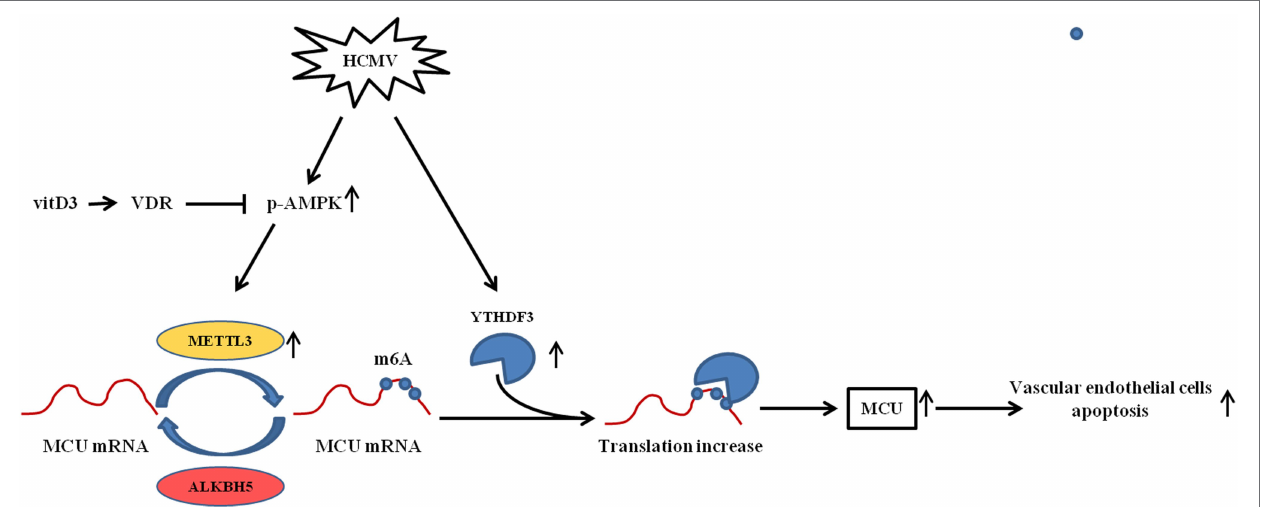
FIGURE 8 | The mechanism diagram of vitamin D3 inhibiting HCMV-induced apoptosis in HAECs. HCMV infection upregulates the expression of METTL3 and YTHDF3. METTL3 methylates MCU at three m6A residues in the 3 ′ -UTR, thereby promoting the binding of RNA-binding protein YTHDF3 to MCU-methylated mRNA and promoting the translation of MCU mRNA. Increased MCU protein expression is responsible for HCMV-induced apoptosis. Vitamin D3 inhibits METTL3 expression via the VDR/AMPK pathway, thereby suppressing the MCU m6A modification and MCU-induced